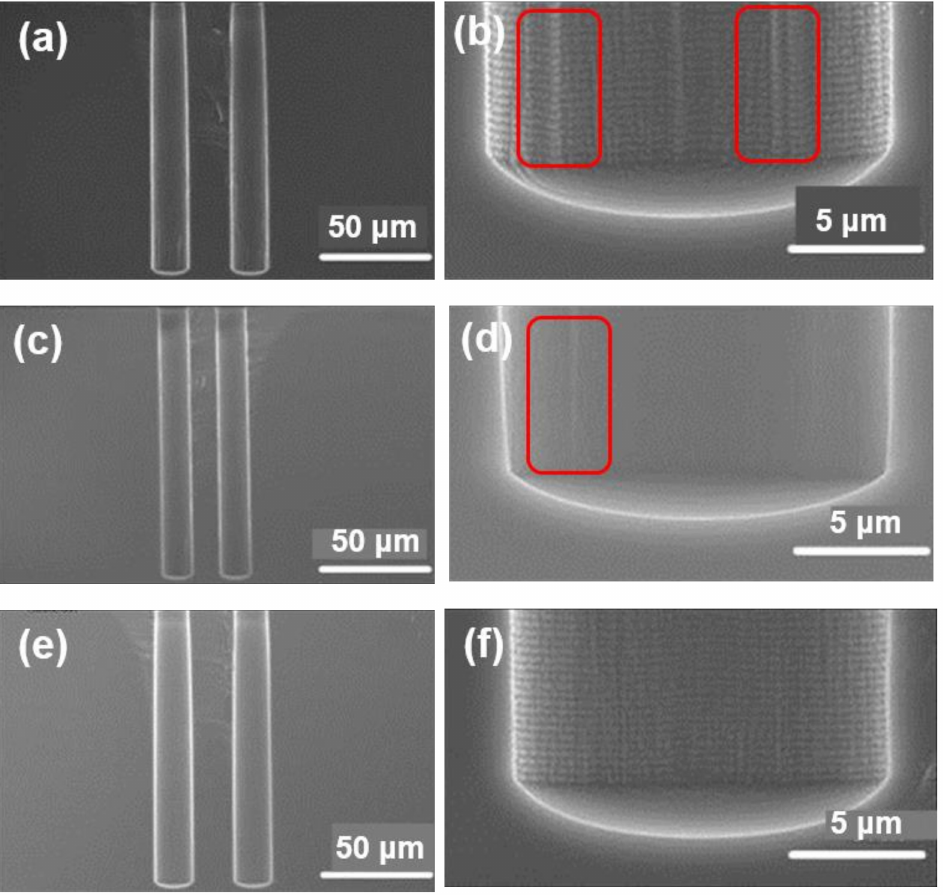
Figure 5. SEM of TSV etch profiles with different etch conditions: ( a , b ) condition 1; ( c , d ) condition 2; ( e , f ) condition